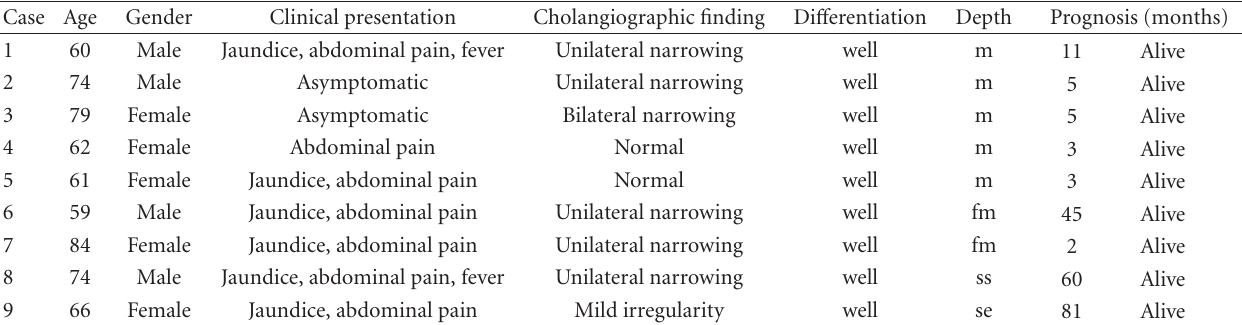
Table 2: Summary of the clinicopathological findings of Group A.